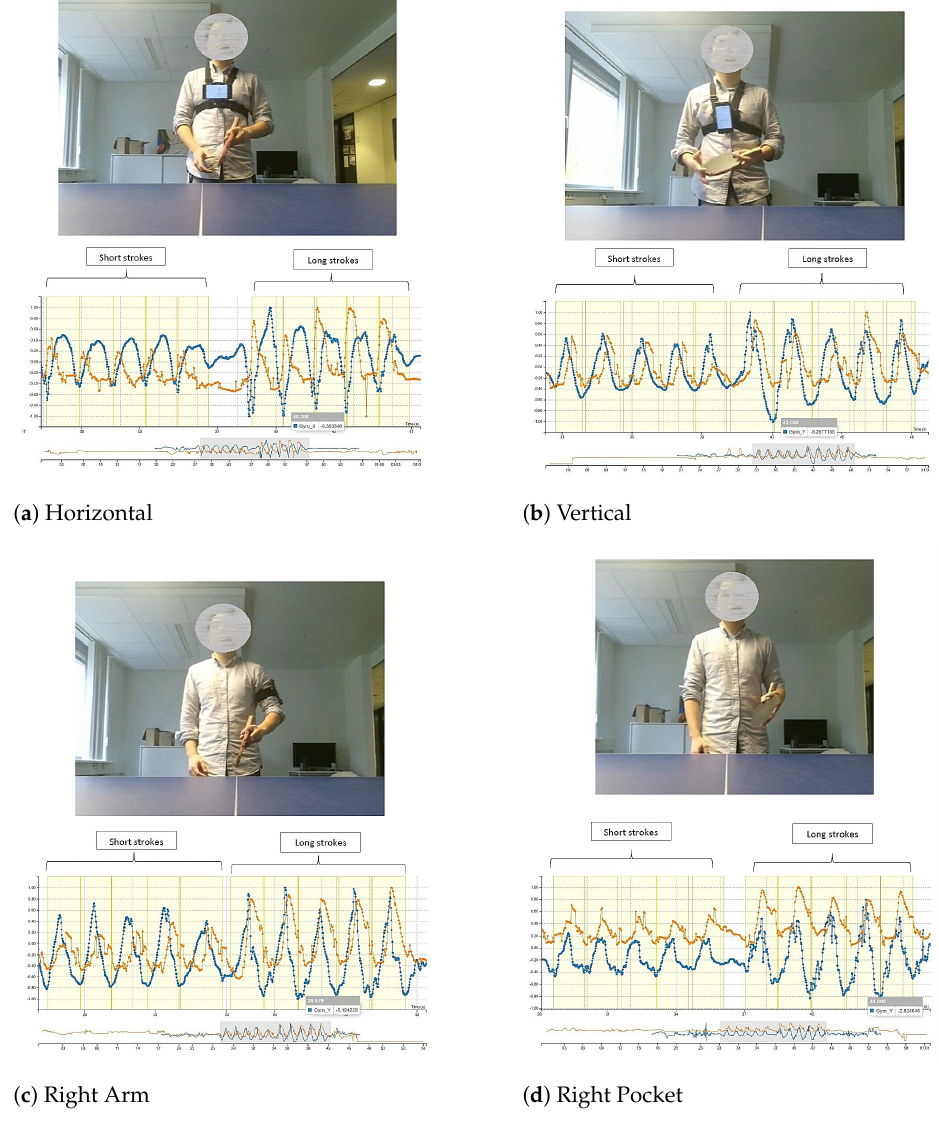
Figure 1. Results of the stroke performance from four different positions with the following attributes: (Blue Lines) Gyro_Y; (Orange Lines)